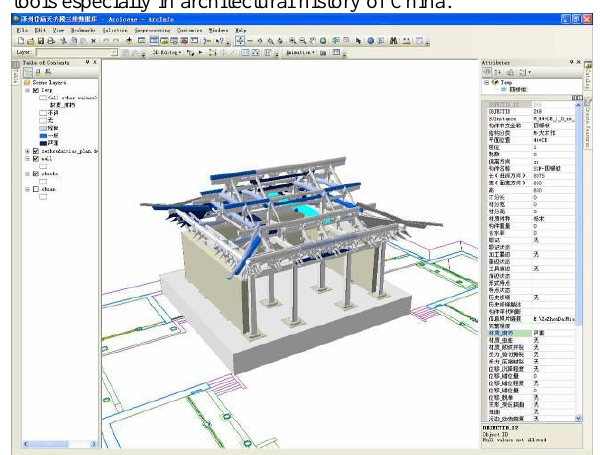
Figure 14 3D Digital Model Database based on ArcGIS.